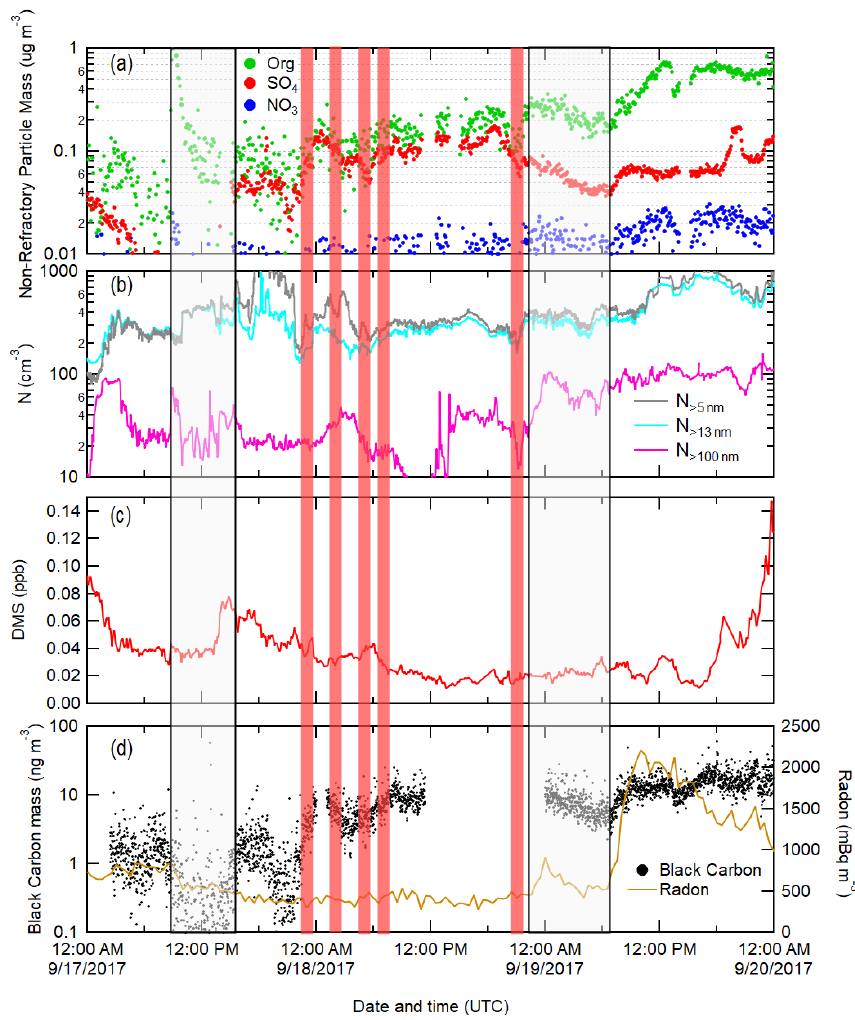
Figure 2. The R/V Atlantis time series of (a) AMS organic, sulfate, and nitrate non-refractory particle mass shown as green, red, and blue points, respectively; (b) particle concentrations greater than 5, 13, and 100nm shown as gray, cyan, and magenta lines, respectively; (c) DMS concentration; and (d) SP2 black carbon and radon concentration shown as black points and a brown line, respectively, over the time frame shown in Fig. 1. Particle concentrations > 100nm are measured with an scanning mobility particle sizer (SMPS) with the exception of a ∼ 1d period (18 September) in which the SMPS was not operational. For this period, the DMPS measurements are shown. Black carbon measurements are not available for a ∼ 12h period on 18 September when the SP2 was not operational. The two opaque boxed areas represent approximate periods in which air mass transitions occurred. The first transition (17 September, 08:00–16:00UTC) was a result of the passing of an occluded front with a region of open-cell clouds following (Fig. 1a–e), and the second transition (22:00UTC on 18 September–07:00UTC on 19 September) is a result of the ship entering a polluted air region. The red vertical lines mark the 1h period of measurements used in Table 3